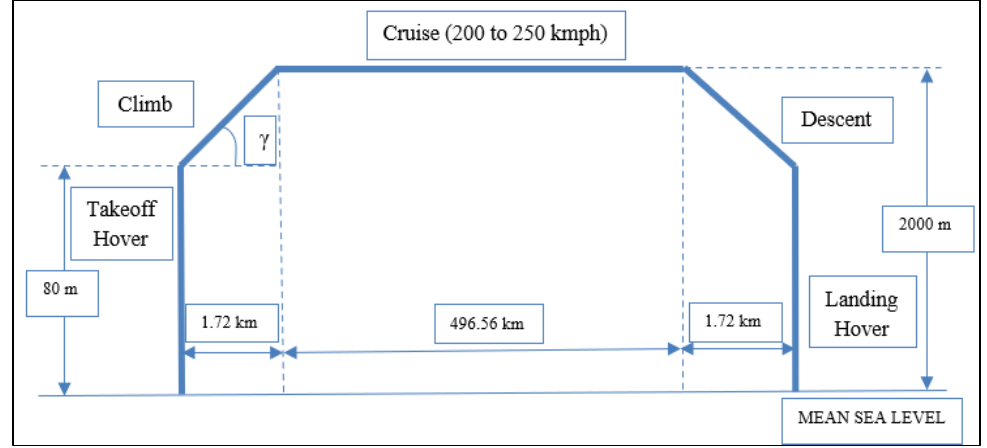
Figure 4. Mission profile.